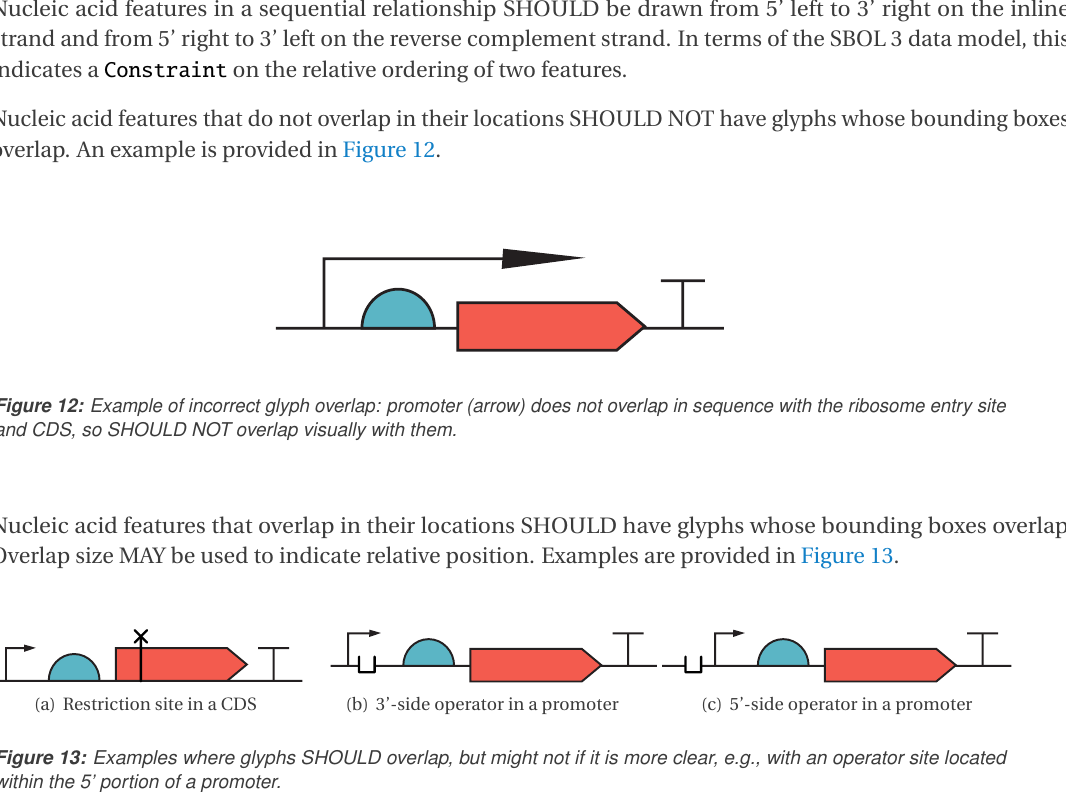
6. A nucleic acid feature SHOULD be represented using a glyph defined in Appendix A.1. In this case, the feature